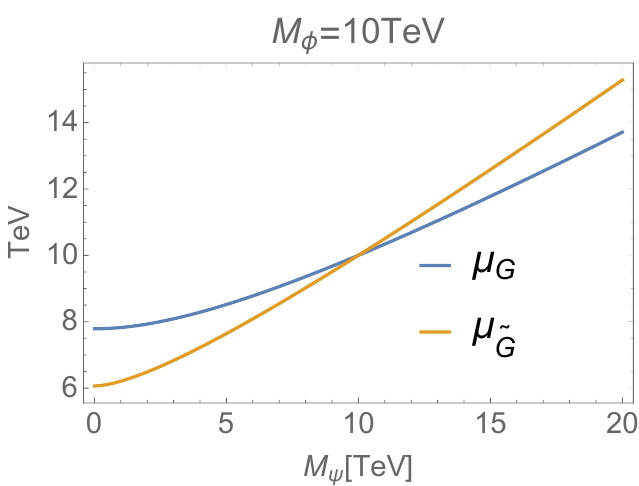
( (cid:30) ) is (cid:12)xed to be (cid:30)